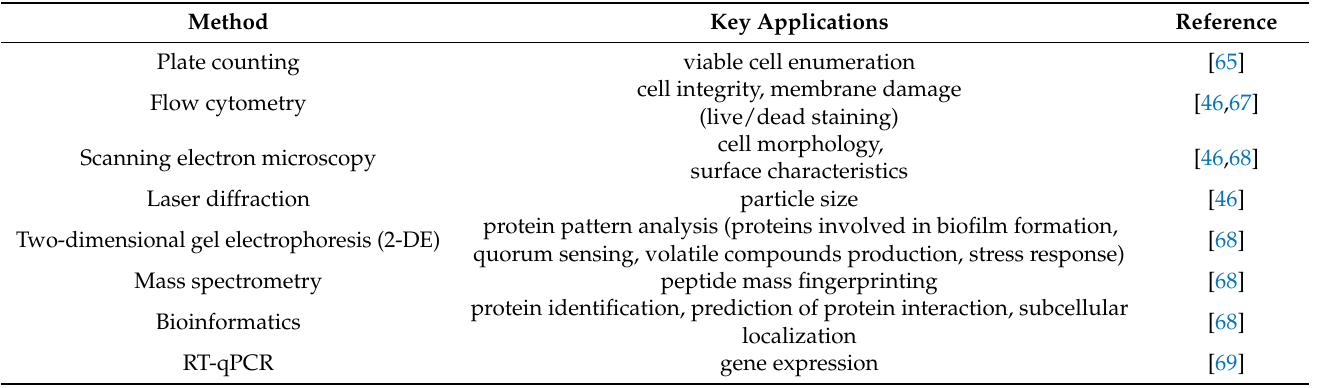
Table 4. Methods for the assessment of